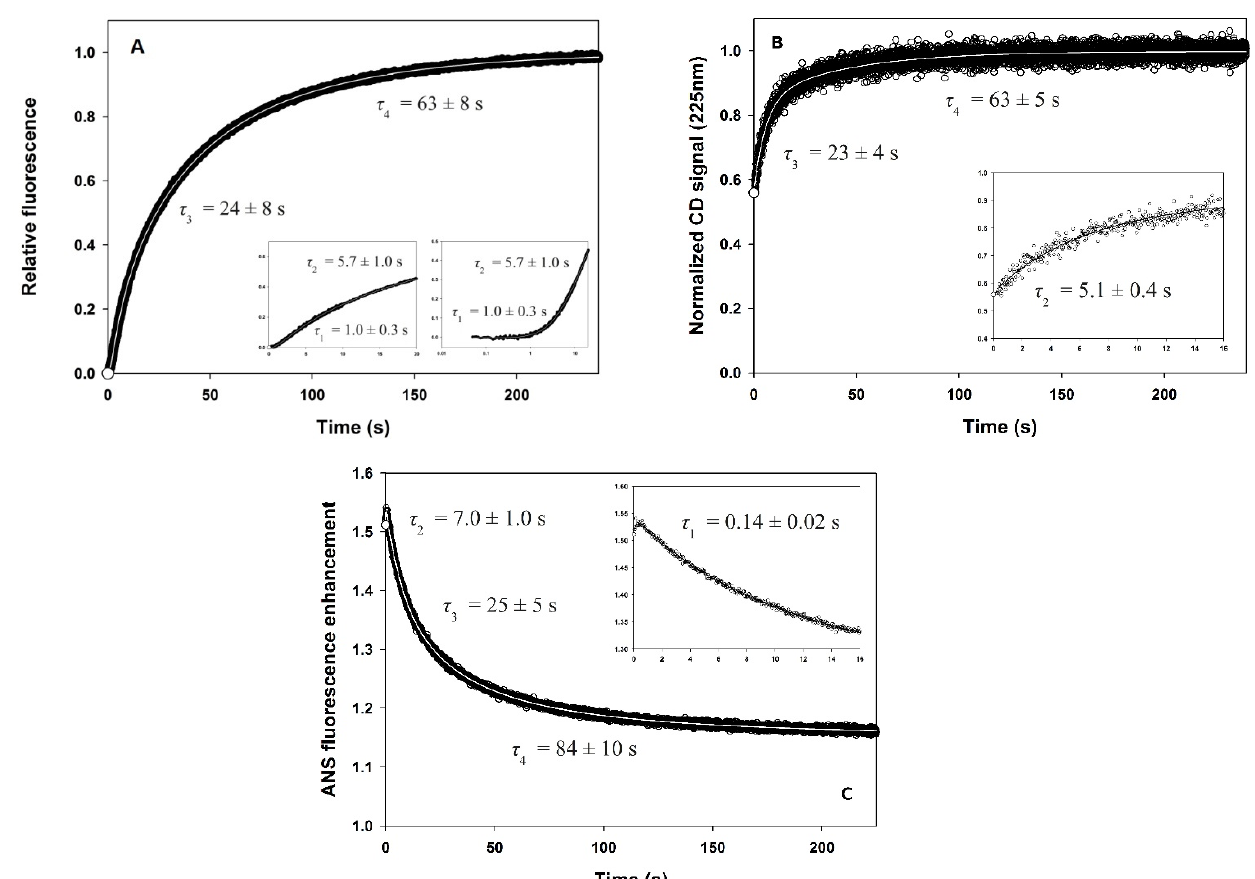
Figure 5. Refolding kinetics of PemA at pH 7, 25 °C, in 0.4 M GdmCl and 50 mM sodium phosphate, monitored by ( A ) total